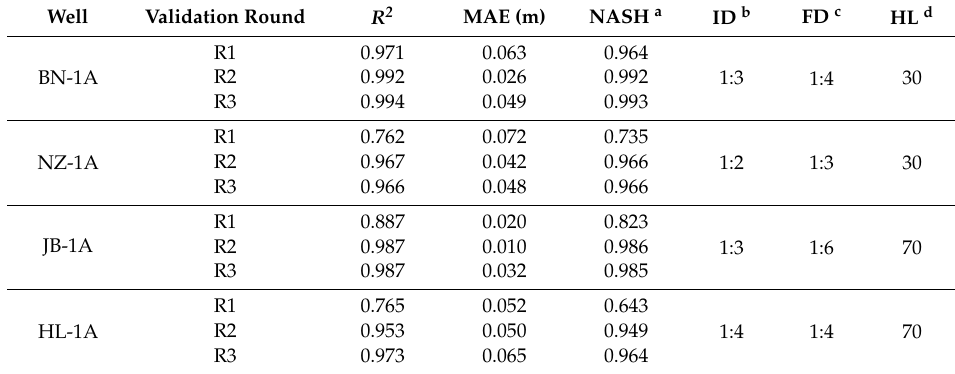
Table 3. NARX models performance at each validation round (R1: round 1, R2: round 2, and R3: round